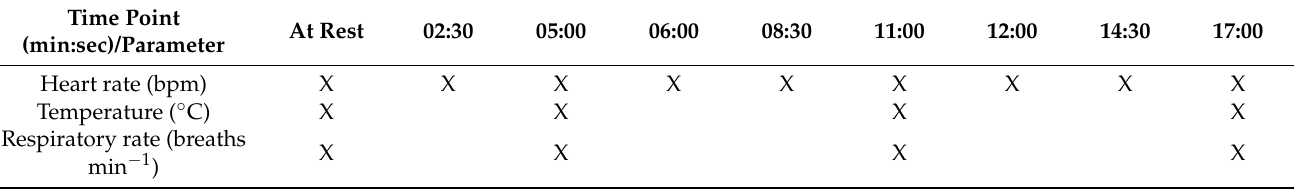
Table 1. Measurement time points for heart rate (beats per minute (bpm)), rectal body temperature ( ◦ C), and respiratory rate (breaths per minute (breaths min − 1 )). Time points at which measurements were performed are marked with an